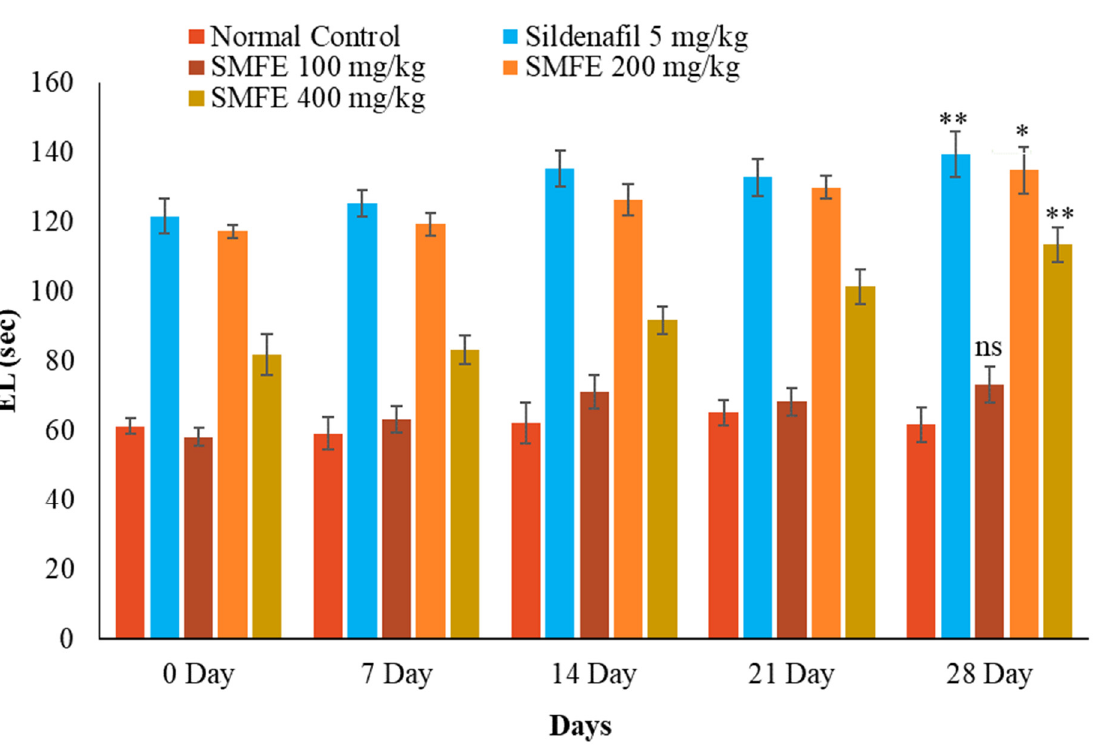
Figure 9. Effect of S. mangifera fruit extract on ejaculation latency ( n = 6). The values are means ± SEM; * p < 0.05, ** p < 0.1; ns p > 0.05 (followed by Student Dunnett test).